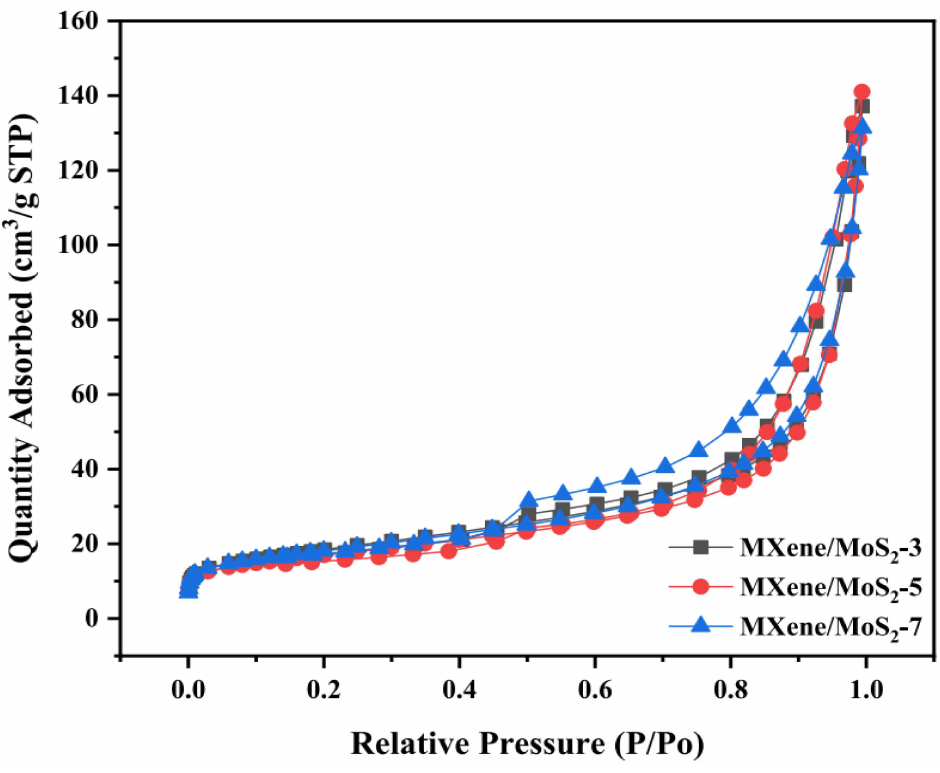
Figure 14. Nitrogen adsorption–desorption isotherms during BET testing. Reproduced with permis- sion from [87]. Copyright 2022 Elsevier. Table 2. Average references of pore size of MXene/MoS 2. Reproduced with permission from [86]. Copyright 2020